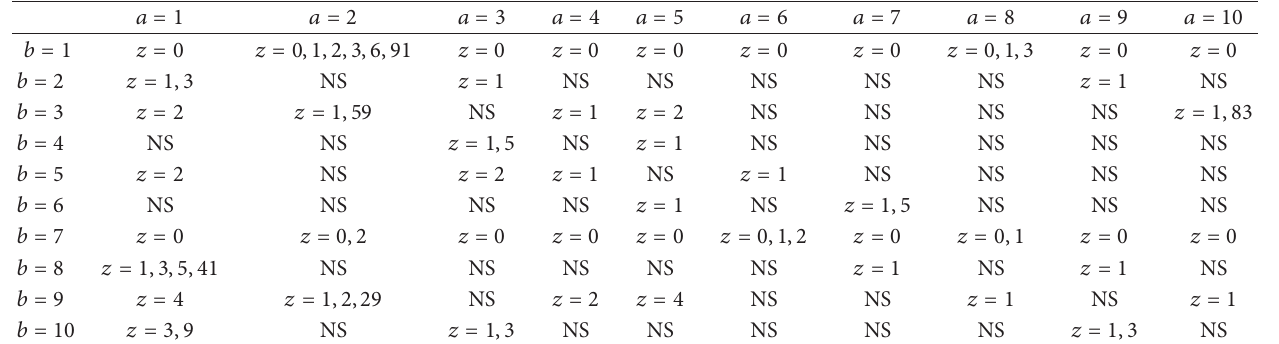
Table 2: Positive 𝑧 -value of the